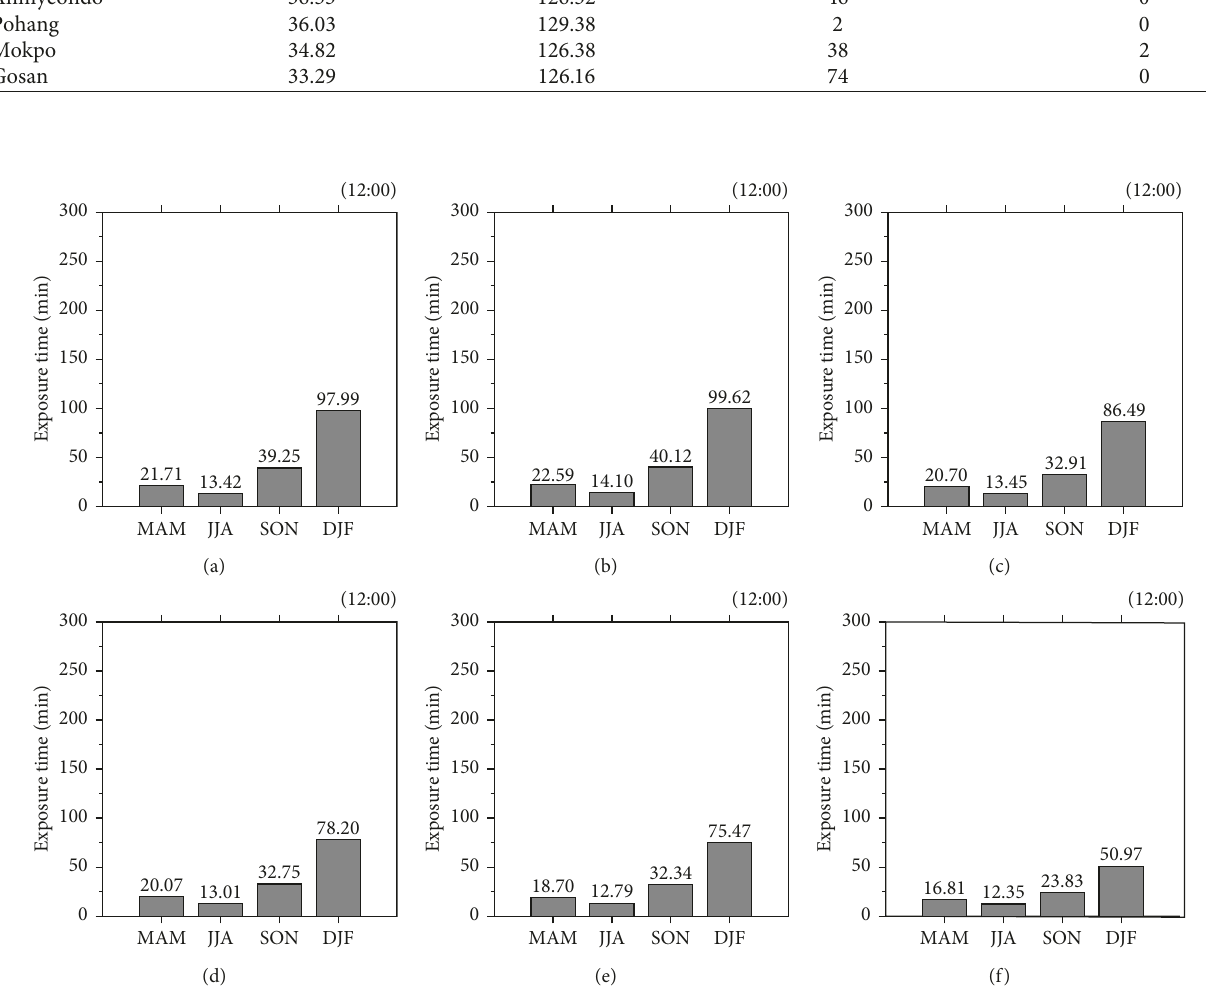
Figure 4: Seasonal average of threshold exposure time for vitamin D synthesis at 6 different stations at noon in (a) Seoul, (b) Gangneung, (c) Anmyeondo, (d) Pohang, (e) Mokpo, and (f) Gosan.